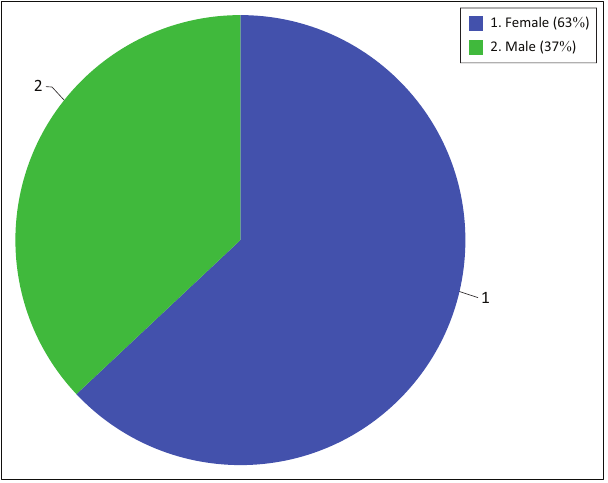
FIGURE 2: Characteristics of the study